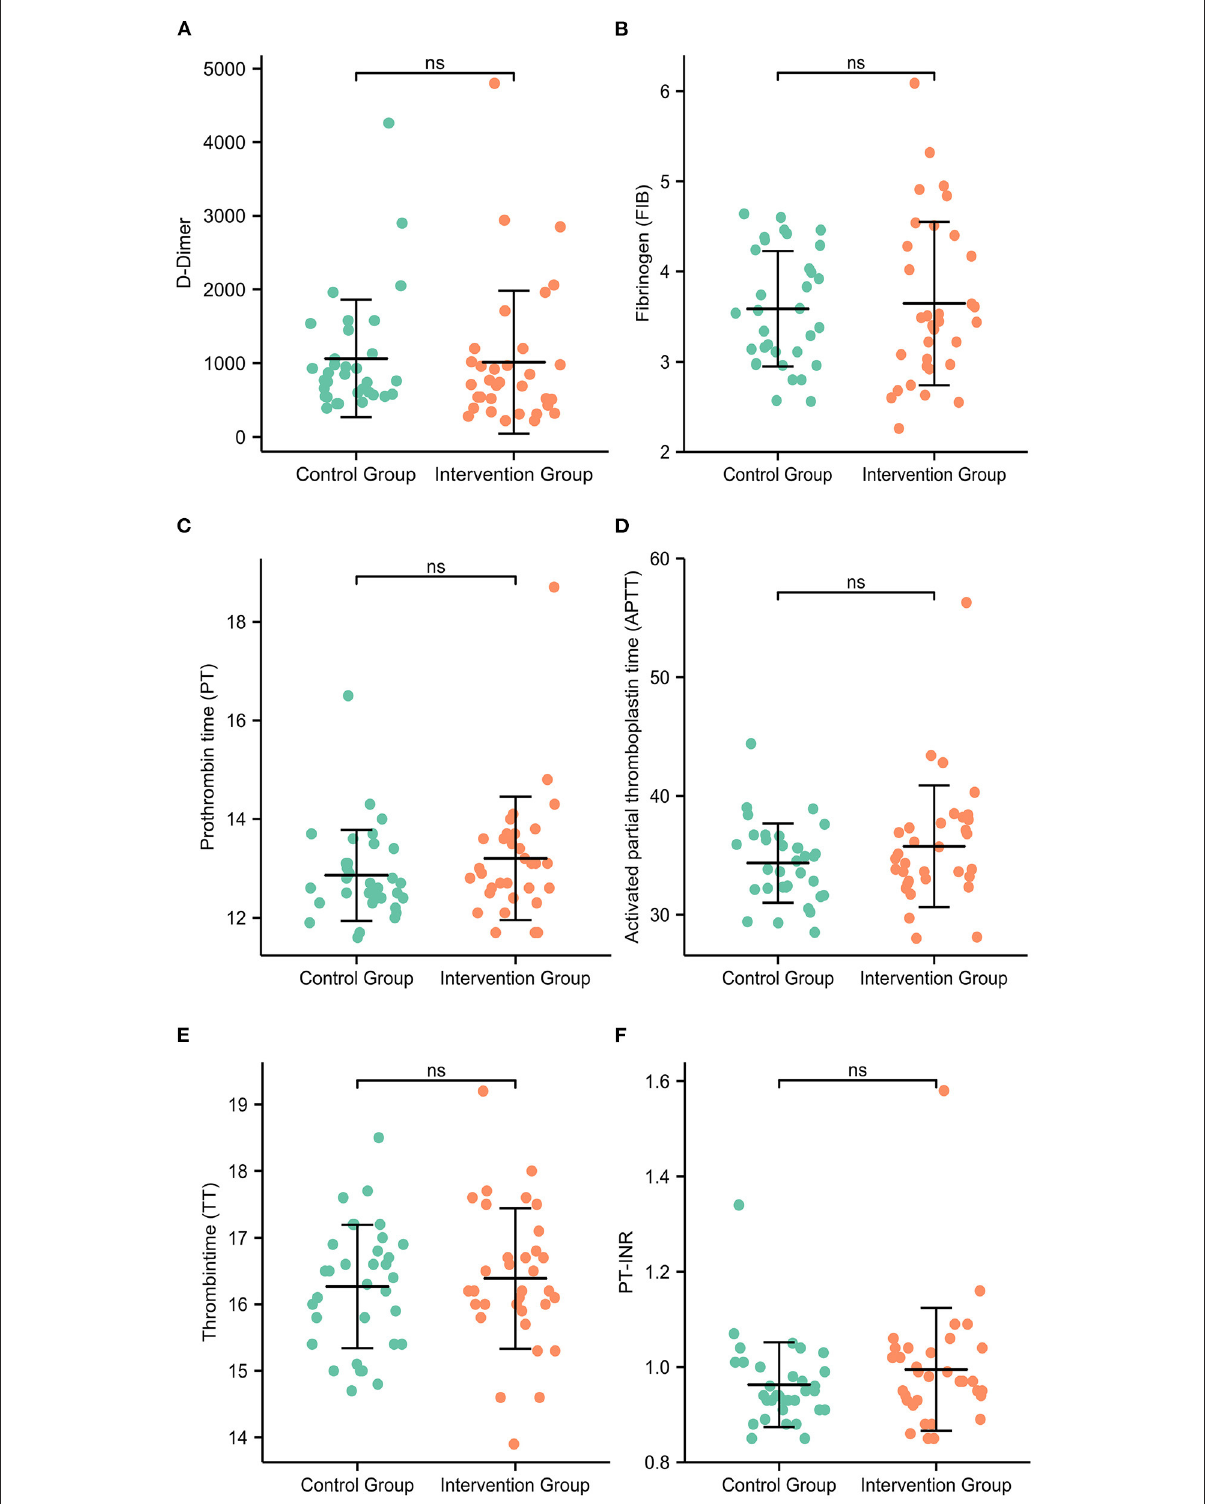
FIGURE2 The coagulation indices of patients at the 3-month follow-up. There were no statistically significant differences in the expression levels of D-dimer (A) , fibrinogen (B) , prothrombin time (C) , activated partial thromboplastin time (D) , thrombin time (E) or PT-INR (F) between the intervention group and the control